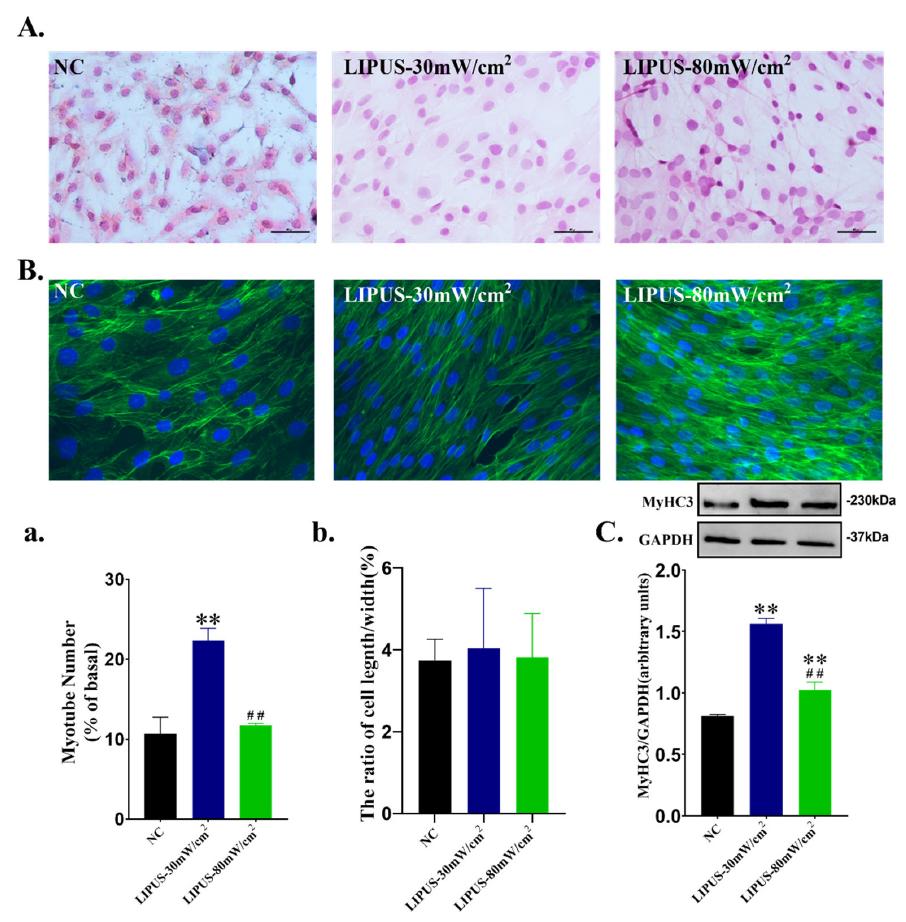
Figure 5. ( A ) HE staining of C2C12 after LIPUS irradiation with different intensities. ( B ) FITC- phalloidin labeled microfilament immunofluorescence staining. ( C ) MyHC3 protein expression of C2C12. ( A ( a )) The number of myotubes in HE staining ( n = 8 in each group). ( B ( b )) The cell length/width ratio in microfilament staining ( n = 3 in each group). ** p < 0.01 vs. NC group, ## p < 0.01 vs. LIPUS ‐ 30 mW/cm 2 group.